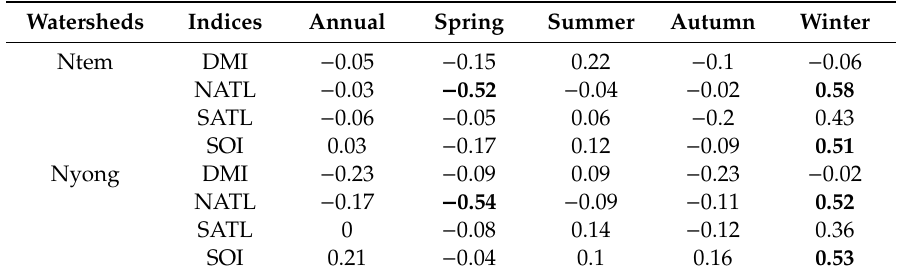
Table 5. Correlation between rainfall indices and climatic indices at annual and seasonal time steps. Significant correlations are in bold.